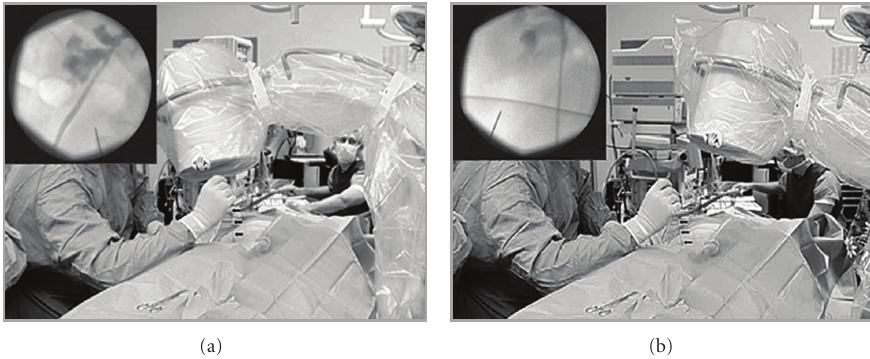
Figure 1: Triangulation technique for percutaneous access. Fluoroscopic C-arm is moved back and forth between 2 positions, including 1 parallel and 1 oblique to puncture line. A, with C-arm oriented parallel to puncture line, adjustments with access needle (arrows) are made in mediolateral (left/right) direction. Inset, corresponding fluoroscopic image. B, C-arm is rotated to oblique position, and adjustments with access needle are made in cephalad/caudal (up/down) orientation of puncture line. Inset, corresponding fluoroscopic image. (Reprinted with permission from The Journal of Urology, Vol. 178, Miller NL, Matlaga BR, and Lingeman JE. Techniques for Fluoroscopic Percutaneous Renal Access, pp 15–23, Copyright Elsevier 2007.)